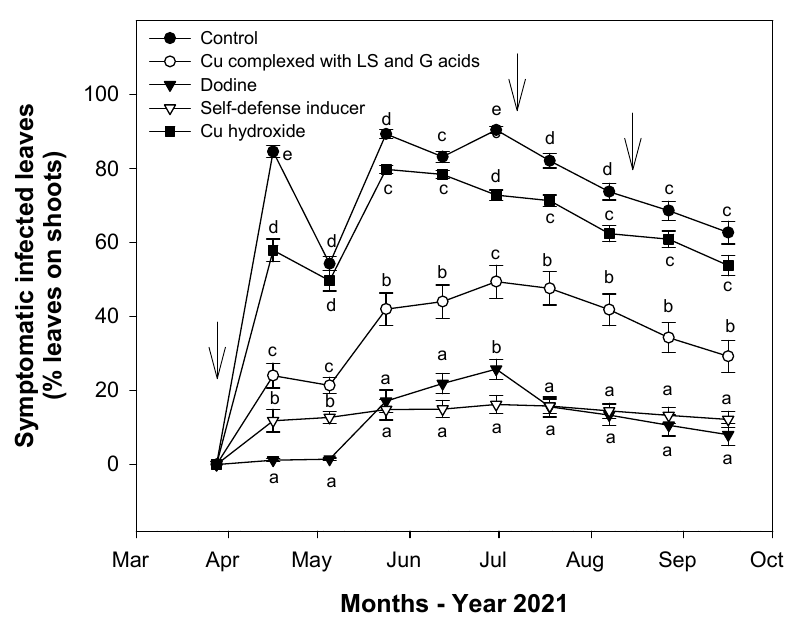
Figure 4. Effect of chemical treatments on symptomatic Venturia oleaginea infection in new leaves (grown in 2021). Arrows indicate the dates of fungicide application. Bars represent the standard error. For each date, means followed by different letters are significantly different at p ≤ 0.05.